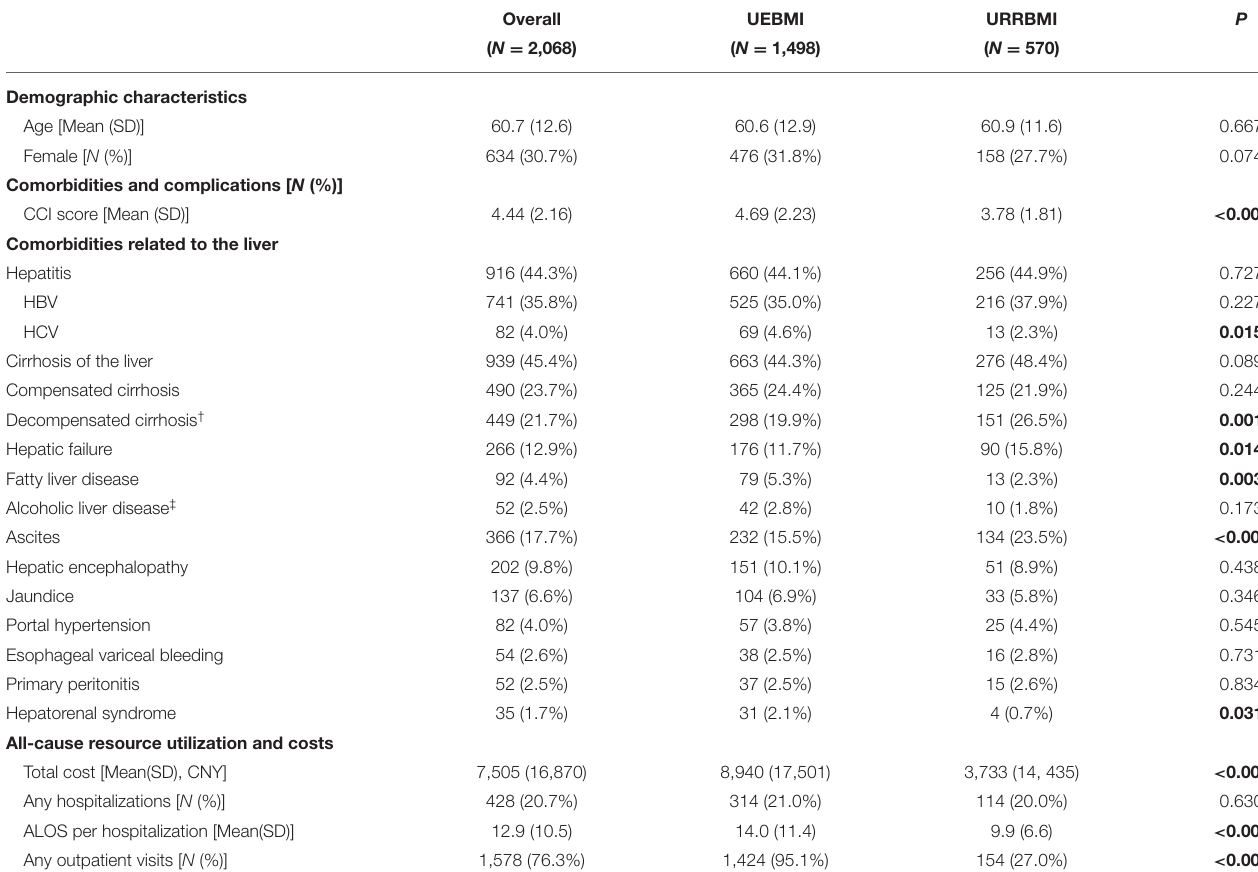
TABLE 1 | Baseline characteristics for patients with